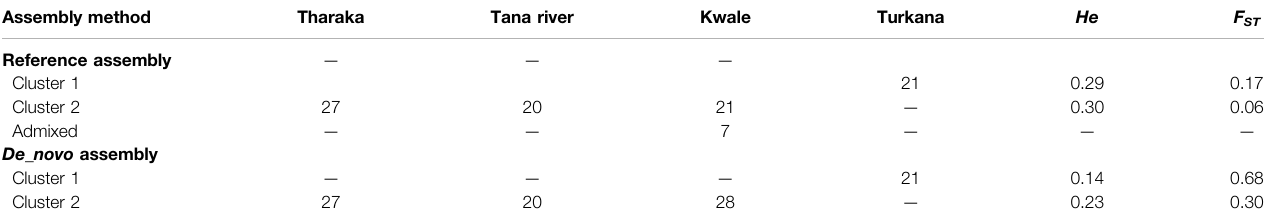
TABLE 1 | STRUCTURE analysis of Hyphaene compressa from Kenya using reference-based and de_novo based assembly. Assembly method